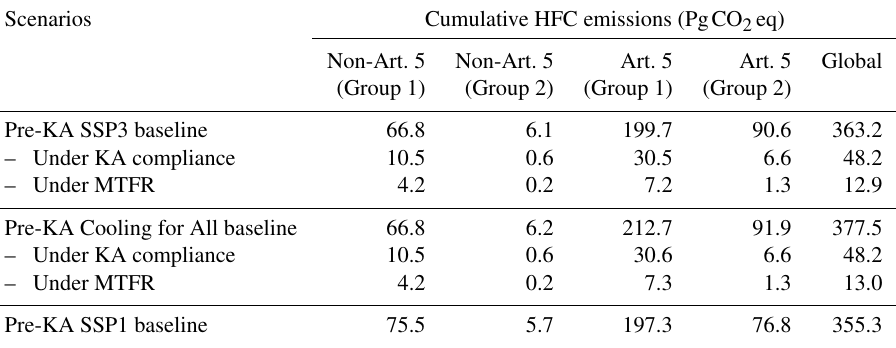
Table 4. Cumulative HFC emissions in the pre-Kigali Baseline and corresponding Kigali Amendment (KA) and maximum technically feasible reduction (MTFR) scenarios by KA party groups and over the entire period 2018 to